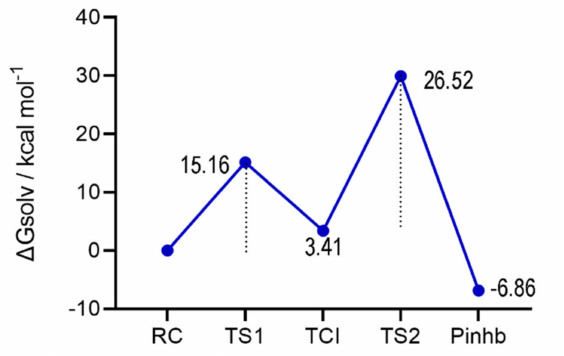
Figure 2. Energy profile for the inhibition mechanism of M pro by EbSe. Activation energies of TS1 and TS2 are relative to the RC and TCI, respectively. Energies are reported in Table S2 (Supplementary Materials). Level of theory: SMD-B3LYP-D3(BJ)/6-311G(d,p), cc-pVTZ//B3LYP-D3(BJ)/6-311G(d,p),